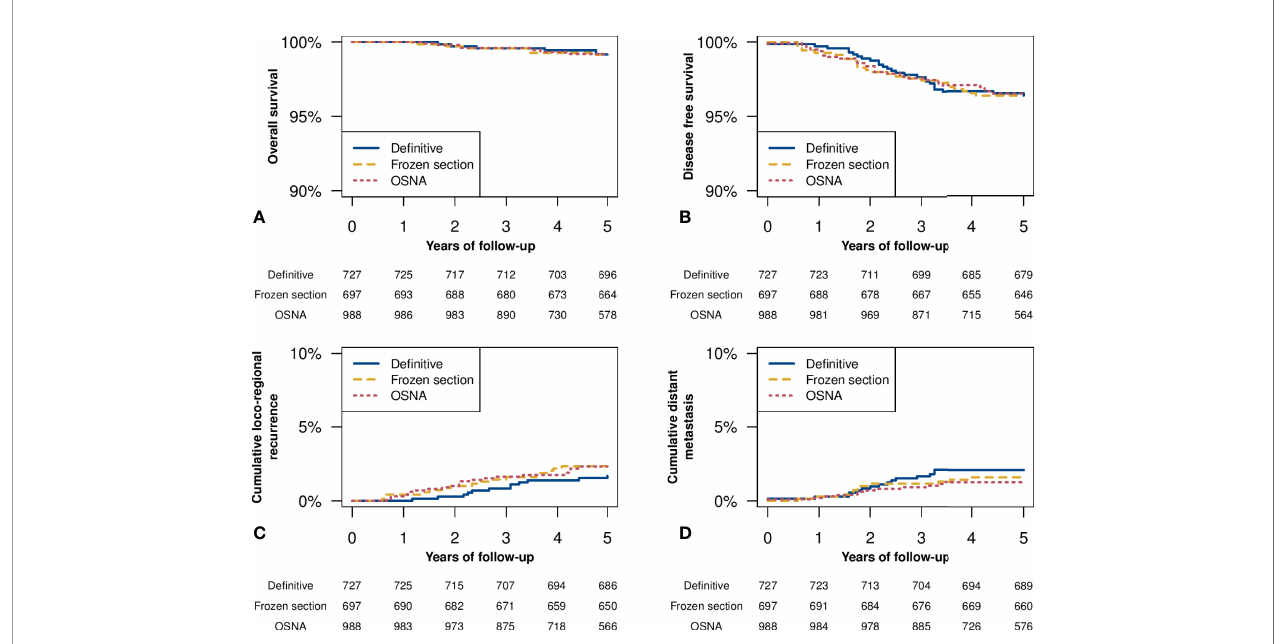
FIGURE 1 | Kaplan Meier analysis. (A) Overall survival among the studied groups (log-rank test p-value=0.806). (B) Disease free survival among the studied groups (log-rank test p-value=0.295). (C) Cumulative loco-regional recurrence among the studied groups (log-rank test p-value=0.152). (D) Cumulative distant metastases among the studied groups (log-rank test